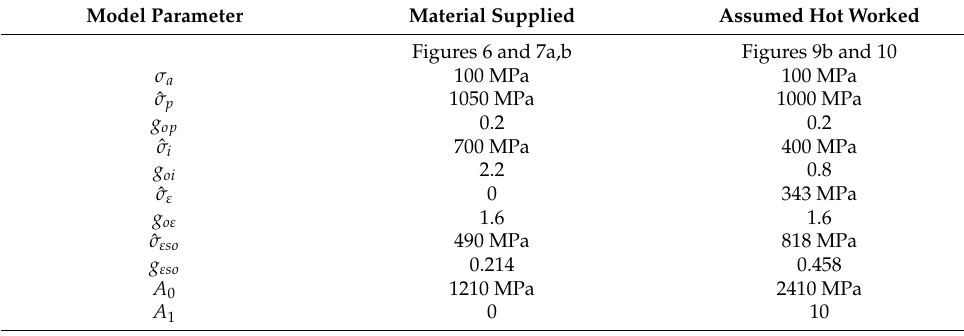
Figure 6. Yield stress versus temperature and strain rate in measured in Follyalloy. Table 3. Model parameters for Figures 6, 7a,b, 9b and 10.